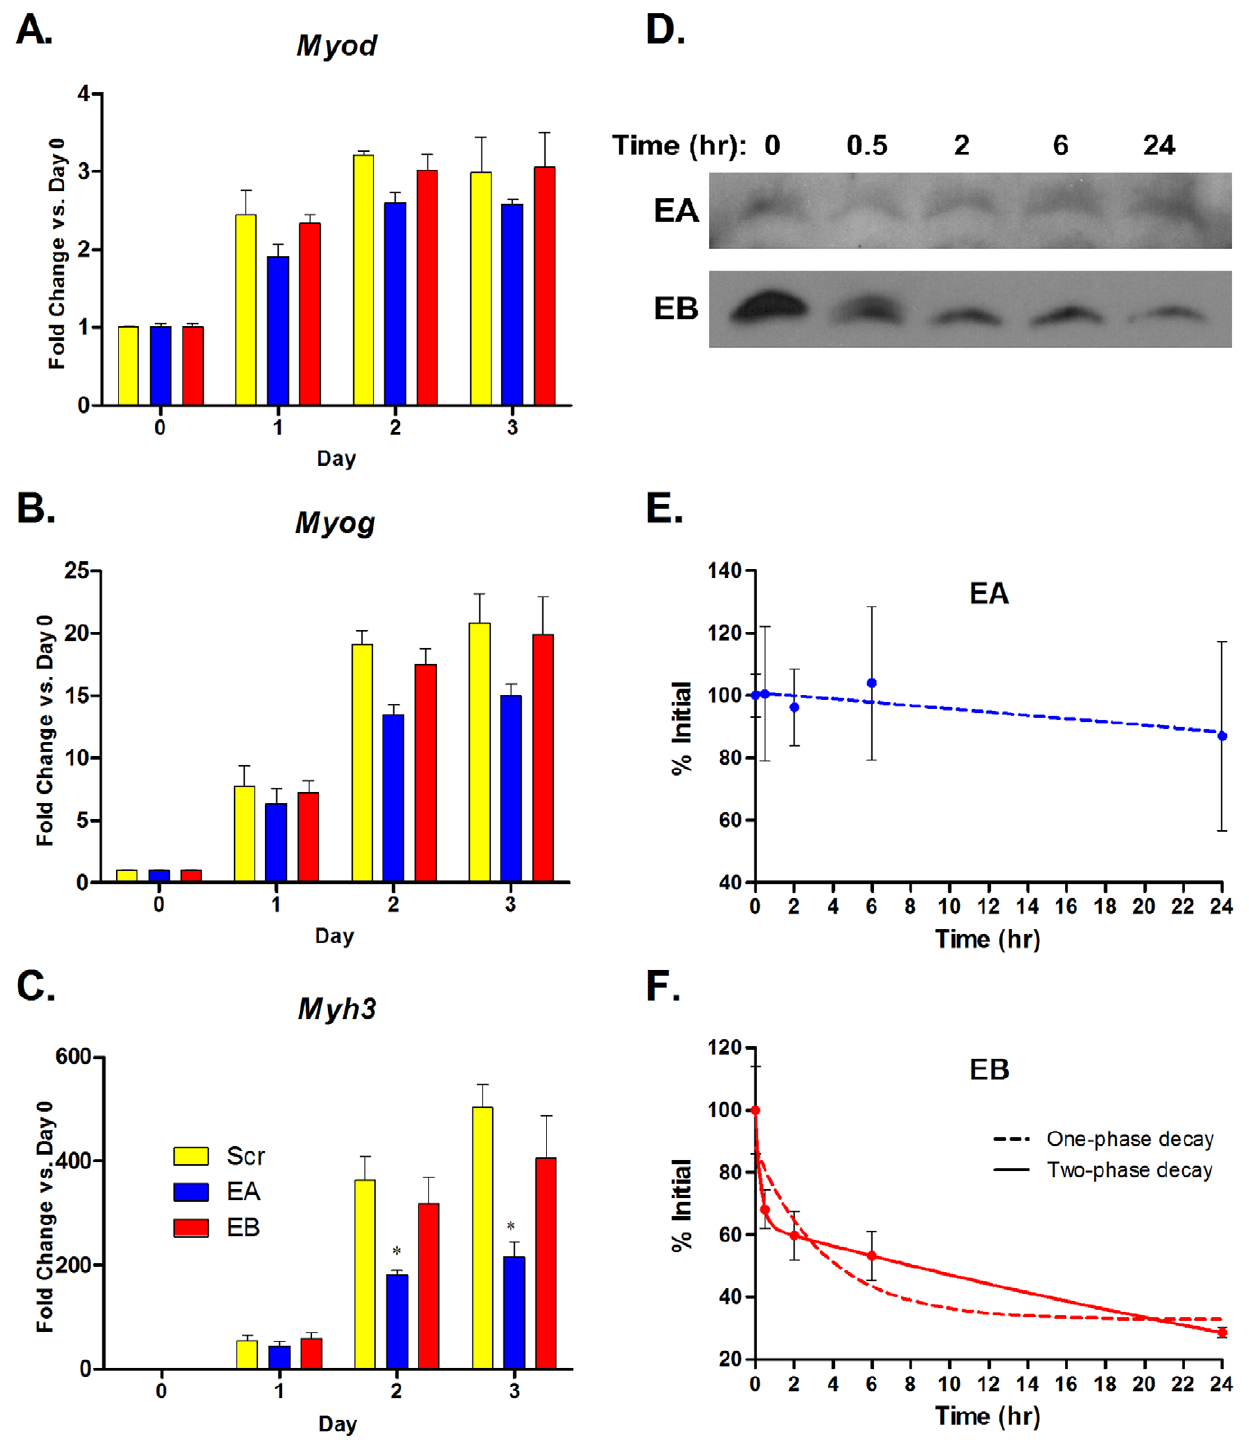
Figure 7. E-peptides inhibit myoblast differentiation. A–C . C2C12 cells were grown to confluency and switched to differentiation media (Day 0). Media was changed every day and synthetic peptides (100 nM) were added to the fresh media. Quantitative RT-PCR was used to measure expression of differentiation markers: MyoD ( Myod , A), Myogenin ( Myog , B), Embryonic Myosin ( Myh3 , C). Expression of the markers at Days 1, 2, and 3 were compared to Day 0 to obtain fold change. Bars represent fold change means 6 s.e.m. of N=3 replicates. *, p , 0.05 for fold change expression comparisons via 2-way ANOVA followed by a Bonferroni post-test. D . Synthetic EA and EB peptides were incubated with growth media and aliquots were taken at times indicated for immunoblotting analysis. E–F . Quantification of (D) and analysis of peptide half-life. Bars represent percent of original intensity 6 s.e.m. of N=3 replicates.